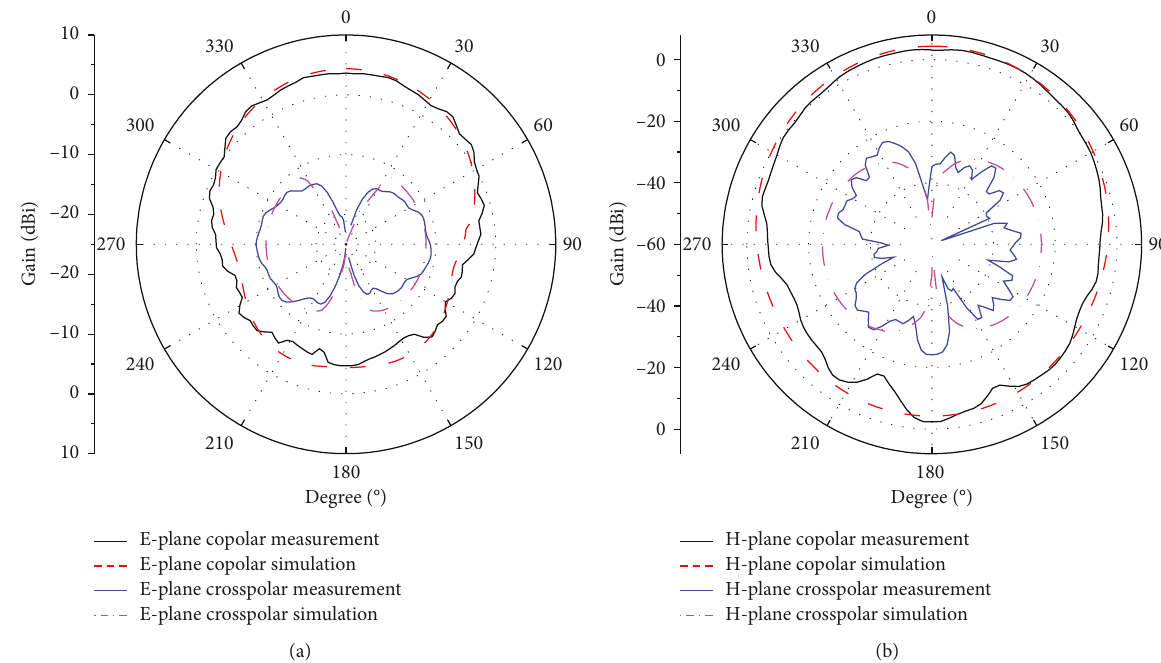
Figure 8: Simulated and measured radiation patterns of the proposed MA at 2.59GHz (a) E-plane (b) H-plane.